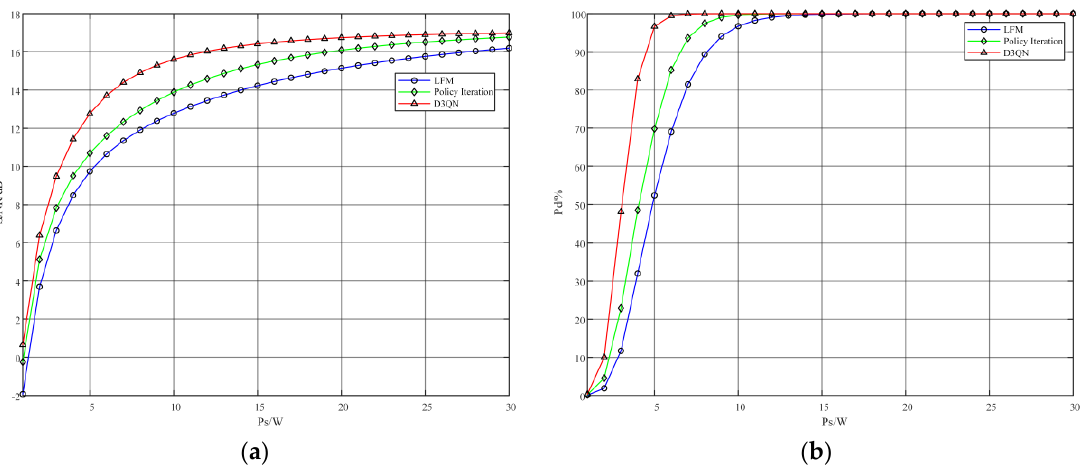
Figure 11. Performance of different signals when radar power changes. ( a ) the signal-to-jamming plus noise ratio (SJNR) of different transmitted signals; ( b ) detection probability of different trans- mitted